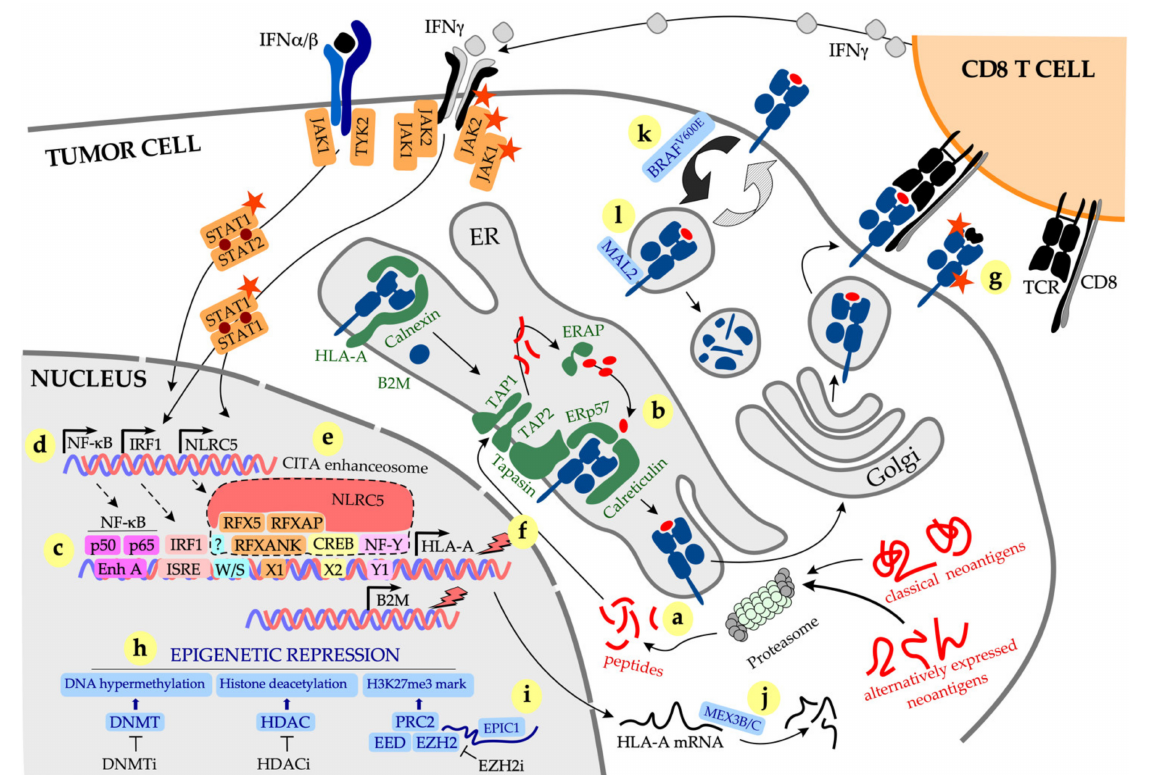
Figure 1. Regulation and alterations of MHC class I expression in cancer. Peptide-MHC class I (pMHC-I) complexes are assembled in the endoplasmic reticulum (ER) and transported to the cell surface via Golgi and secretory vesicles. ( a , b ) Classical or alternate neoantigen peptides are generated in the cytosol by the proteasome ( a ), transported to the ER by transporter associated with antigen processing (TAP1 and 2), trimmed by ER aminopeptidases (ERAP) to the optimal size and loaded onto MHC-I molecules with the help of antigen processing machinery complex consisting of tapasin, ER protein 57, and calreticulin ( b ). ( c ) Expression of MHC-I heavy chains is subject to regulation by transcription factors binding to multiple sites in the MHC-I promoter region. (d) Expression of the nuclear factor kappa-light-chain-enhancer of activated B cells (NF-kB), interferon regulatory factor 1 (IRF1) and the master regulator of MHC-I expression, Nucleotide- binding oligomerization domain-Like Receptor family Caspase recruitment domain containing 5 (NLRC5) is upregulated by interferons, in particular IFN γ , produced by T cells after pMHC-I recognition. ( e ) NLRC5 assembles the class I transactivator (CITA) enhanceosome that binds to four distinct sites (W/S, X1, X2, Y1 boxes) within the MHC-I promoter. ( f ) MHC-I expression is affected by mutations and deletions in the MHC-I heavy chains and beta-2 microglobulin ( B2M ) genes (indicated by lightning), as well as loss-of-function mutations in the components of the IFN signaling complex, such as in IFN γ receptor, the associating adaptors Janus kinases 1 and 2 ( JAK1/2 ) and the transcription factor Signal transducer and activator of transcription 1 ( STAT1 ) (mutations in proteins are indicated with stars). ( g ) pMHC-I recognition by CD8 T cells is also affected by mutations in the α 3 domain [CD8 co-receptor binding] and α 1/ α 2 domains [peptide-binding groove; spectrum of displayed peptides]. ( h ) MHC-I expression is subject to epigenetic regulation, with DNA hypermethylation, histone deacetylation and trimethylation of histone 3 lysine 27 (H3K27me3) by polycomb repressive complex 2 (PRC2) all resulting in a dramatic reduction of the MHC-I expression. Accordingly, inhibition of DNA Methyltransferases (DNMTi), Histone Deacetylases (HDACi) and the catalytic subunit of the PRC2 complex, Enhancer of Zeste Homolog 2 (EZH2i), increase pMHC-I expression on the surface of tumor cells. ( i – k ) Other mechanisms that negatively regulate MHC-I cell surface expression: epigenetically activated long non-coding (lnc)RNA EPIC1 interacts with and activates EZH2 ( i ), mRNA- binding proteins MEX3B and MEX3C destabilize HLA-A2 mRNA ( j ), mutant BRAF V600E promotes internalization and intracellular sequestration of MHC-I ( k ), MHC-I binding protein Myelin and lymphocyte protein 2 (MAL2) promotes MHC-I endocytosis and degradation ( l ). Abbreviations: BRAF, v-raf murine sarcoma viral oncogene homologue B1; DNMTi, DNA methyltransferase inhibitor; CREB, cAMP response element-binding protein; Enh, enhancer; EZH2, enhancer or zeste homolog 2; H3K27me3, trimethylation of histone 3 lysine 27; HDACi, histone deacetylase inhibitor; NF-Y, nuclear transcription factor Y; MEX3B, Mex3 RNA-binding family member B; RFX5, regulatory factor X5; RFXANK, regulatory factor X associated ankyrin containing protein; TSA, tumor-specific